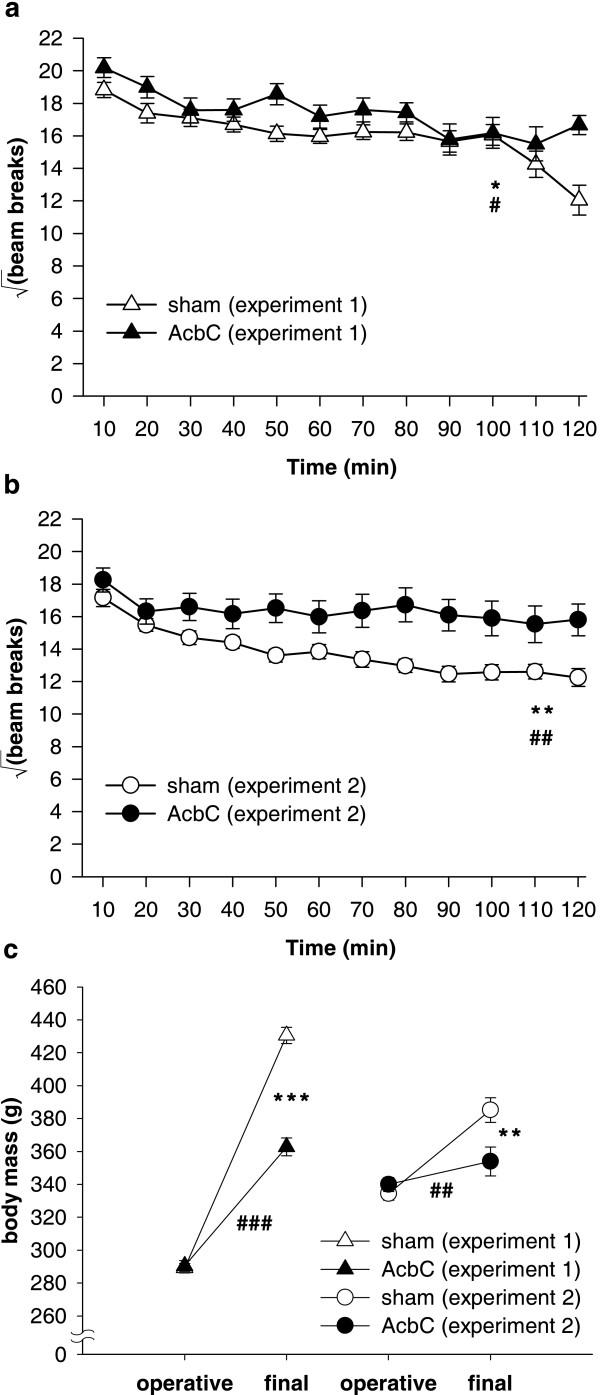
Locomotor activity in a novel environment and body mass AcbC-lesioned rats were significantly hyperactive compared to sham-operated controls, and gained less weight, in both Experiments 1 & 2. (a) Locomotor activity in Experiment 1. Analysis using the model lesion2 × (bin12 × S) revealed effects of lesion (F1,42 = 5.12, * p = .029), reflecting hyperactivity in the AcbC group, with additional effects of bin (F5.7,237.9 = 13.3,  = .515, p < .001), reflecting habituation, and a lesion × bin interaction (F5.7,237.9 = 2.52,  = .515, # p = .024). (b) Locomotor activity in Experiment 2. The same patterns were observed (data from five subjects were not recorded due to a mechanical error; lesion: F1,37 = 9.155, ** p = .004; bin: F9.3,345.2 = 13.5,  = .848, p < .001; lesion × bin: F9.3,345.2 = 3.18,  = .848, ## p = .001). (c) Preoperative and final body mass in both experiments. Preoperatively, masses did not differ between groups (Experiment 1: F < 1, NS; Experiment 2: F1,42 = 1.008, NS), but in both cases, AcbC-lesioned subjects gained less mass than controls (Experiment 1: lesion × time: F1,41 = 95.9, ### p < .001; group difference at second time point: F1,42 = 88.4, *** p < .001; Experiment 2: lesion × time: F1,42 = 13.53, ## p = .001; group difference at second time point: F1,42 = 7.37, ** p = .01).